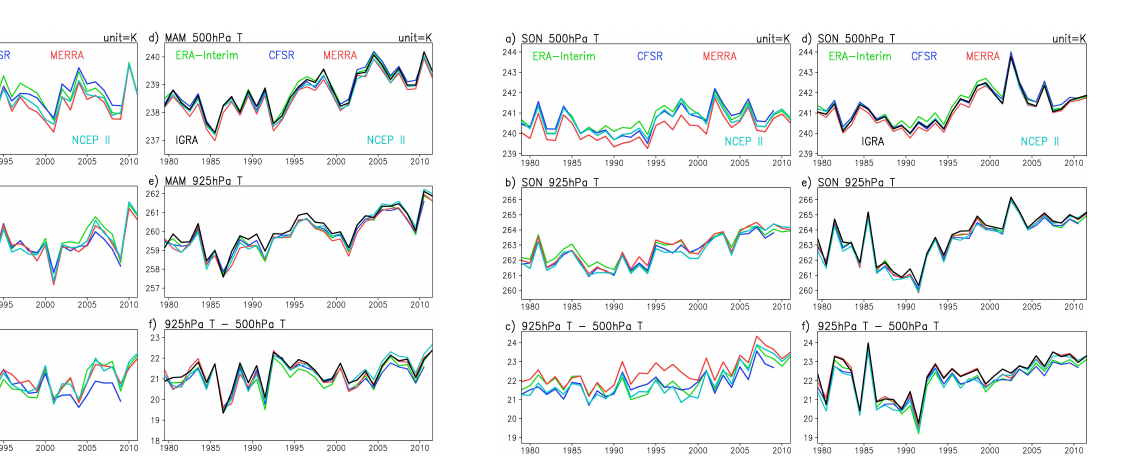
Fig. 5. Same as Fig. 3 except for the SON (September, October and November) season.